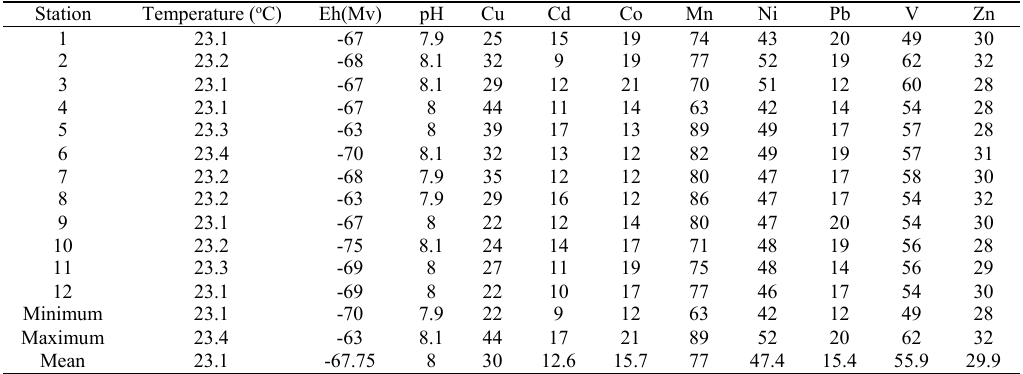
Table 1: Physicochemical specifications and concentrations of the elements in the Persian Gulf within the area opposite to Ofogh Project (Data are expressed in